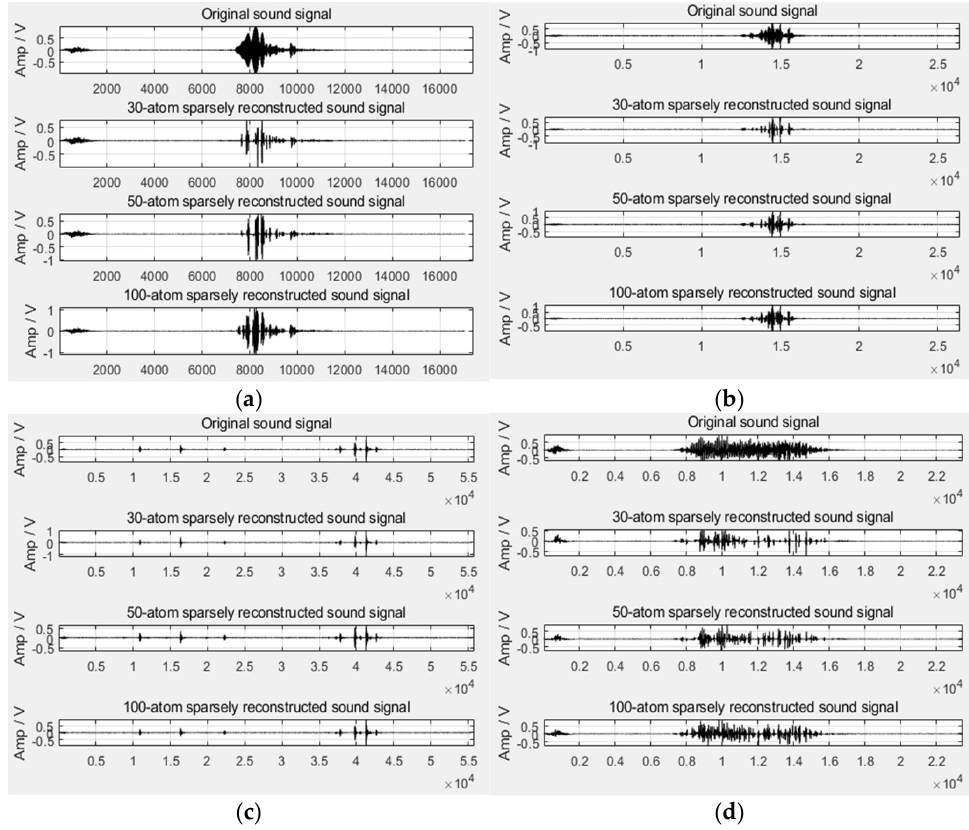
Figure 6. Comparison of sparse reconstruction using different atom numbers of four sound types. ( a ) Crow; ( b ) Cough; ( c ) Purr; ( d ) Flapping wings.